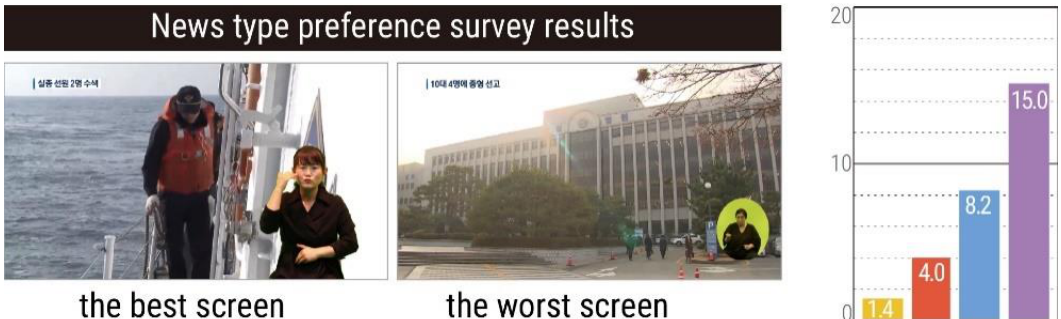
Figure 11. Results of preferences evaluation with news cases. Figure 11 . Results of preferences evaluation with news cases